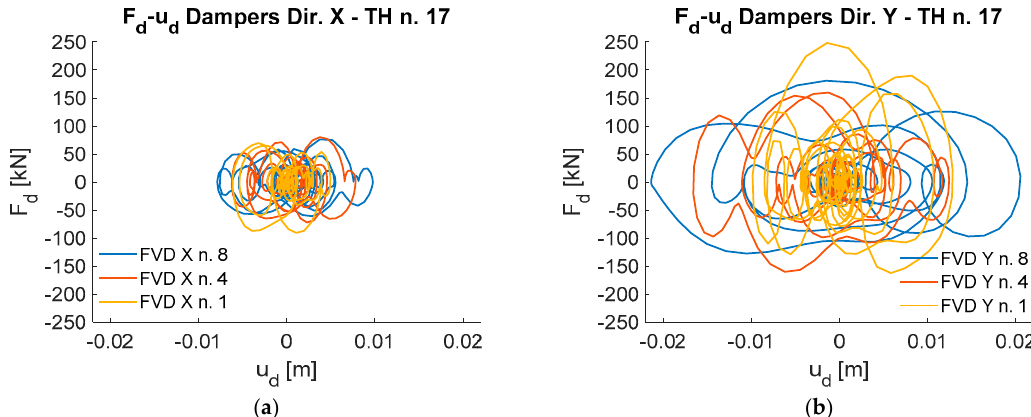
Figure 27. Force-deformation cycles for dampers located at different levels of the inner tower. Nonlinear dynamic analysis TH n. 17: ( a ) X direction; and ( b ) Y direction.